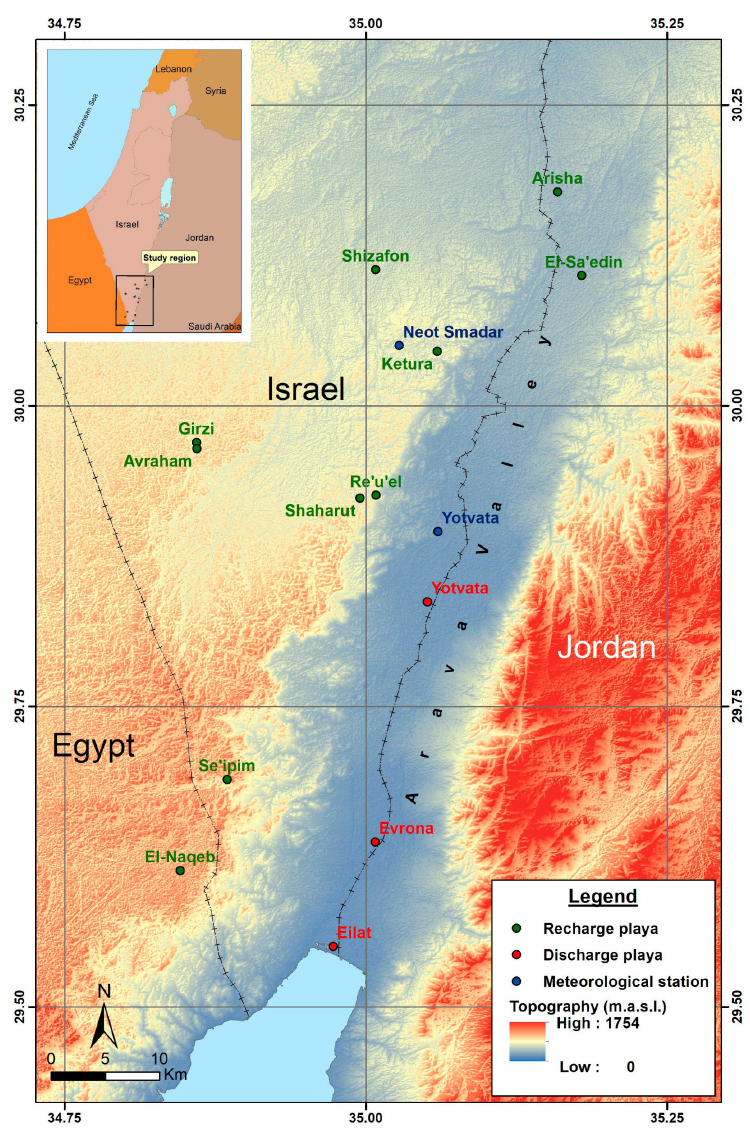
Figure 1. Map of Israel, with an extension of the study